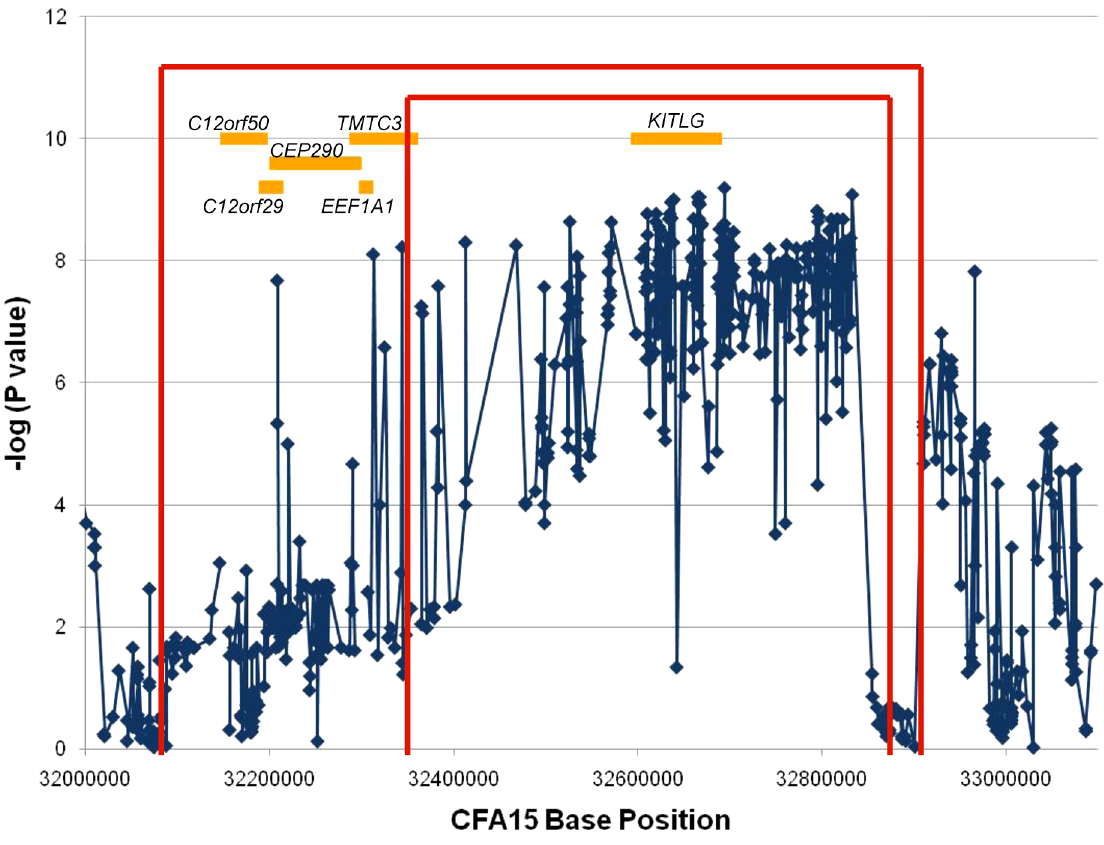
Figure 3. Recombination and association analyses resolve the region to the KITLG locus. The association analysis results for the 658 SNPs with minor allele frequencies . 10% are plotted as the negative log of the uncorrected P value. The X-axis is the base position along CFA15. The results of the recombination analysis are shown as the red brackets with the inner and outer red brackets indicating the one and three recombination intervals respectively. The orange boxes are the known or predicted genes in the region, as labeled.